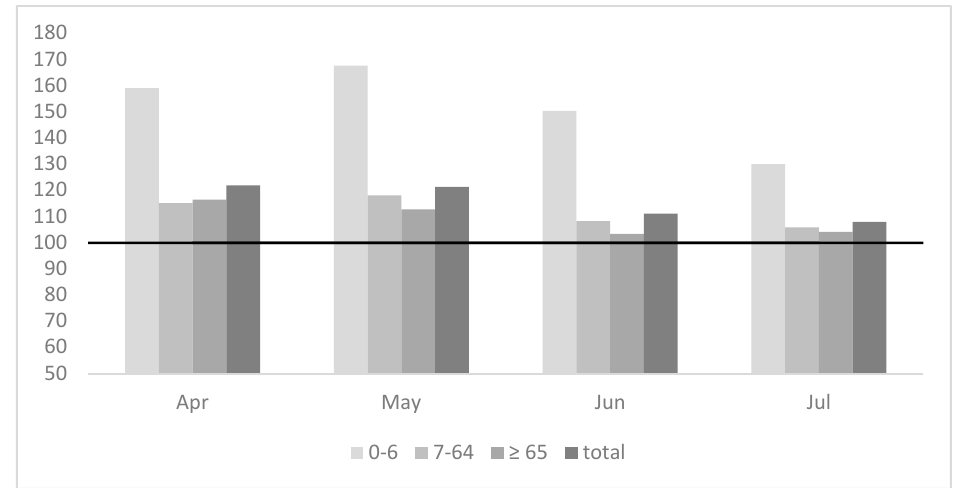
Figure 3. Change in the “Z” codes during the pandemic according to age groups expressed as the percentage of the mean value for the period 2010–2019.